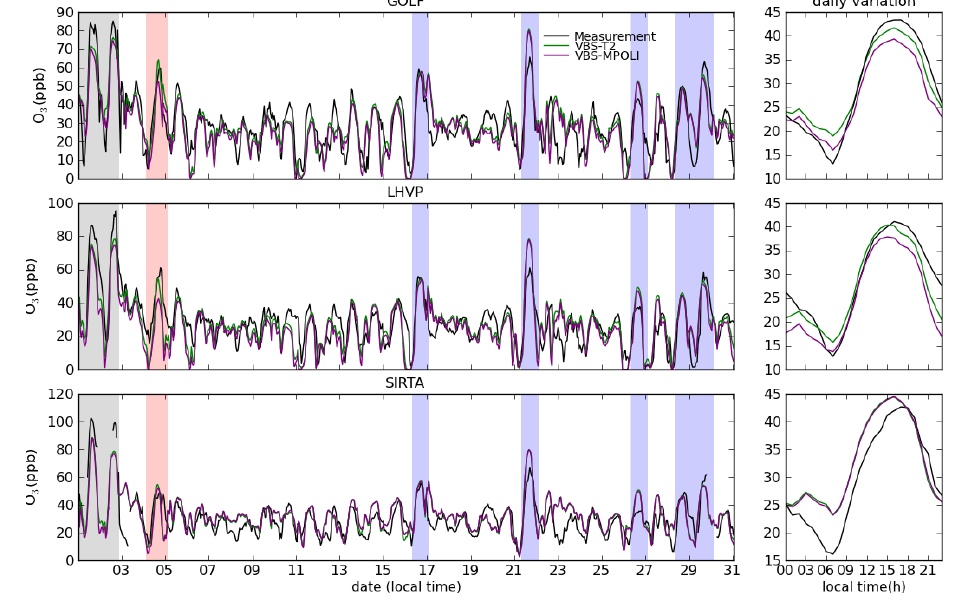
Fig. 5. As for Fig. 4, but for Fig. 5 As for figure 4, but for ozone.